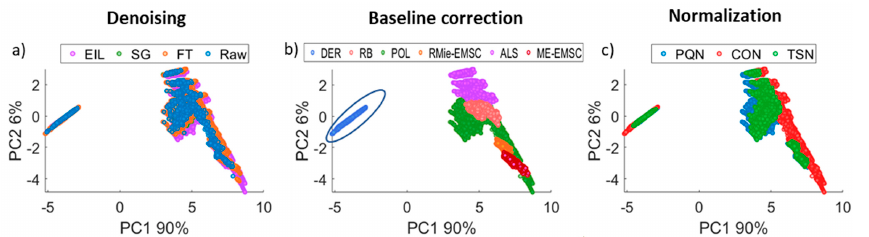
Figure 2. Principal component analysis exploration of the original data structure after application of three preprocessing steps. Each point corresponds to the individual spectrum coming from the original dataset on which unique combinations of the three steps were used. Subsections a, b, and c present the same PC projection but are colored according to a single preprocessing type: ( a ) denoising, ( b ) baseline correction, and ( c ) normalization. For better understanding, a set of spectra on which combinations of DER baseline correction method with other preprocessing steps are marked with a circle.